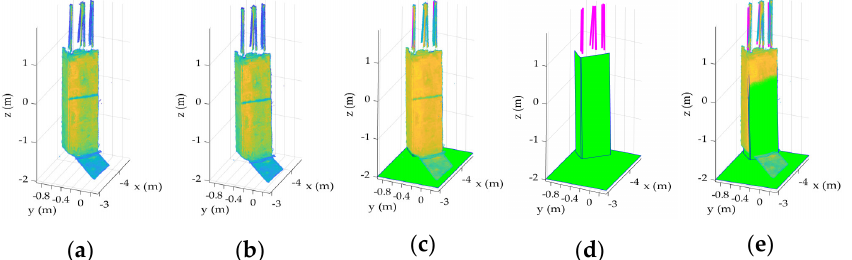
Figure 4. Experimental setup for demonstration 1: ( a ) original point cloud, ( b ) translated and rotated point cloud, ( c ) as-built model of the transformed point cloud of Figure 4b superimposed onto the point cloud, ( d ) as-built model of the transformed point cloud, and ( e ) as-built model of the transformed point cloud superimposed onto the original point cloud.